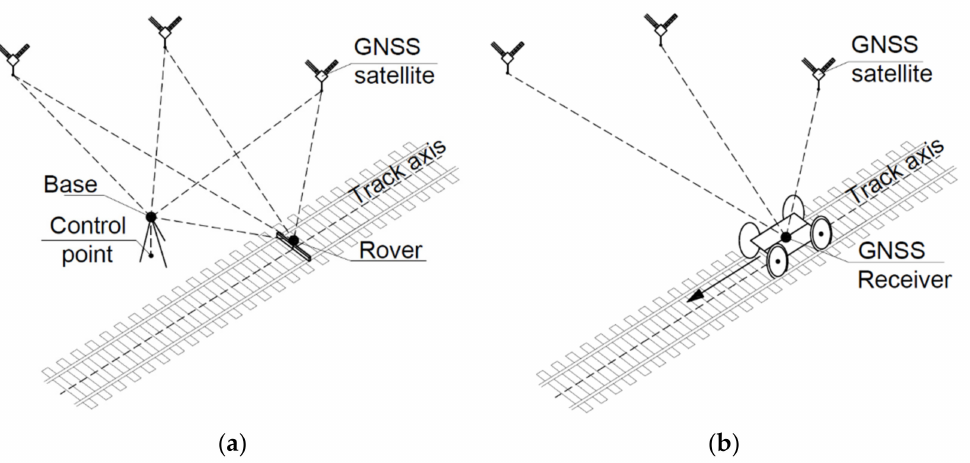
Figure 3. Measurement of railway track axis co-ordinates with two GNSS receivers ( a ) and MSM technique ( b